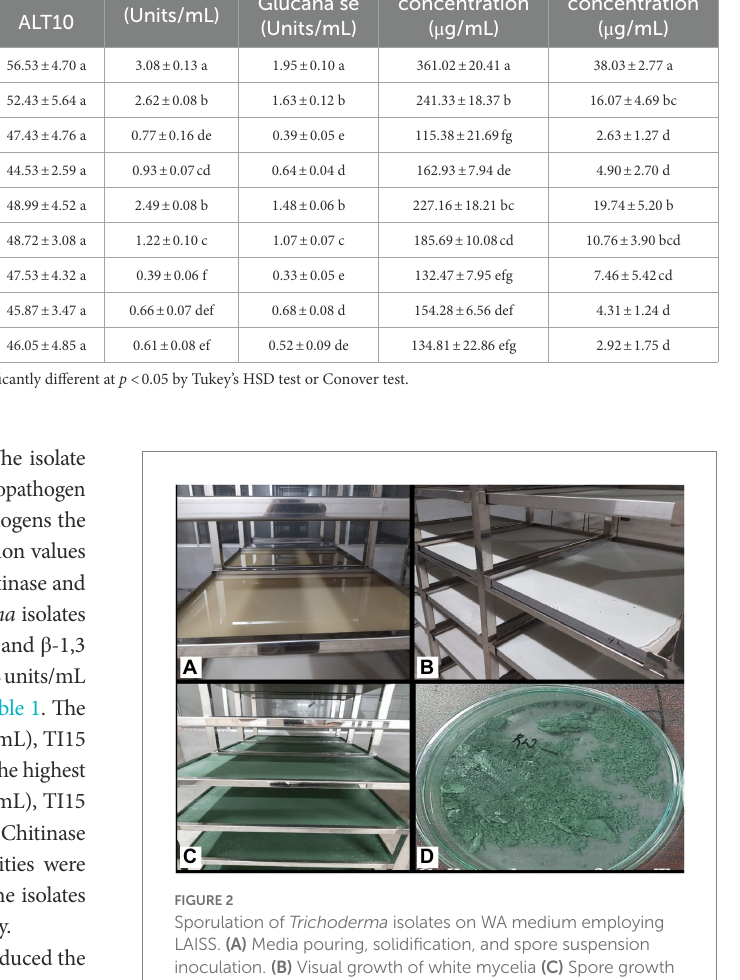
TABLE 1 Bioactivity of Trichoderma isolates: antagonistic activity against phytopathogens, Chitinase and β -1,3-glucanase activity, phosphate solubilization and IAA production. Tricho- derma isolates